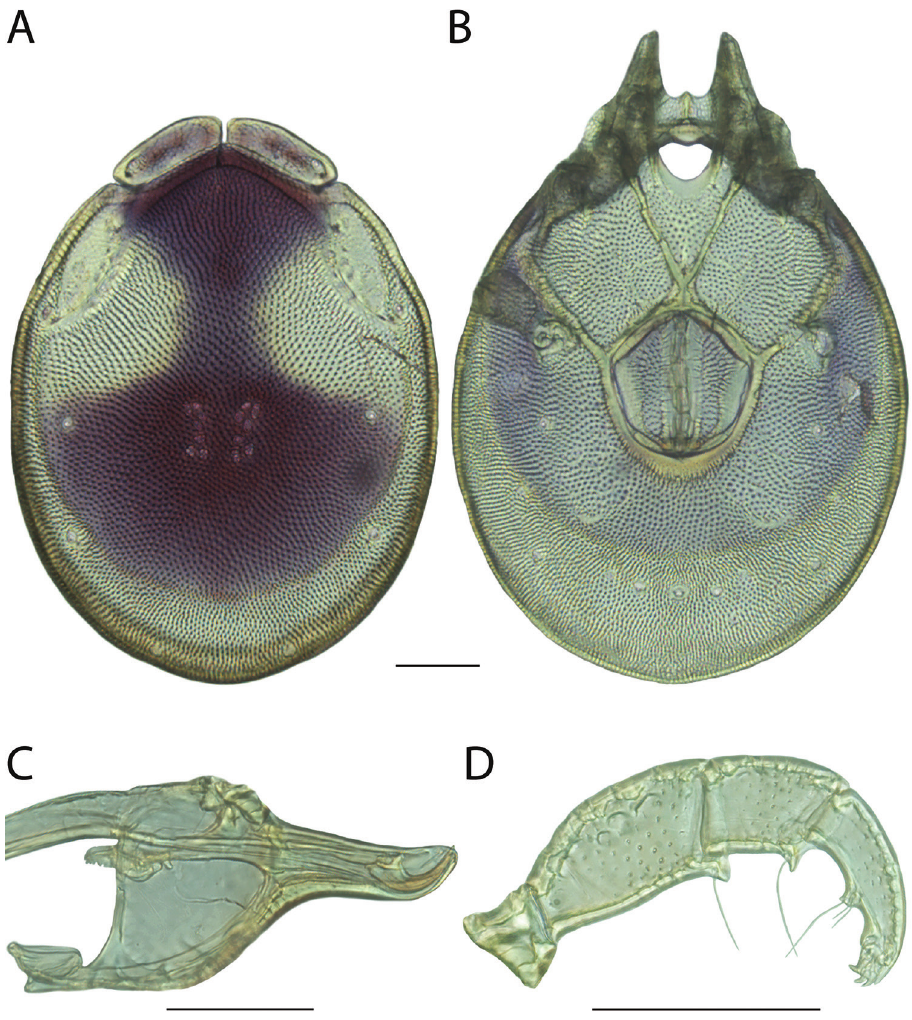
Figure 188. Torrenticola pendula sp. n. female: A dorsal plates B venter (legs removed) C subcapitulum D pedipalp (setae not accurately depicted). Scale = 100 µm.